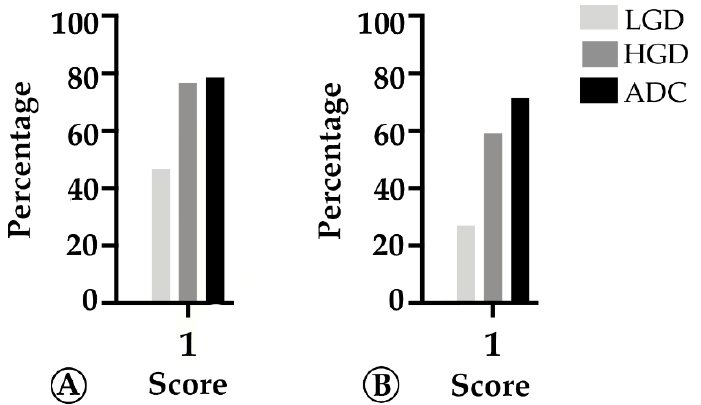
Figure 5. Percentage of cases in which MHC-I in tumor cells is >25% (score 1) along the colorectal adenoma-carcinoma sequence, in sporadic ( A ) and hereditary Familial Adenomatous Polyposis (FAP)-related ( B ) lesions. LGD, low-grade dysplasia; HGD, high-grade dysplasia; ADC, invasive adenocarcinoma.